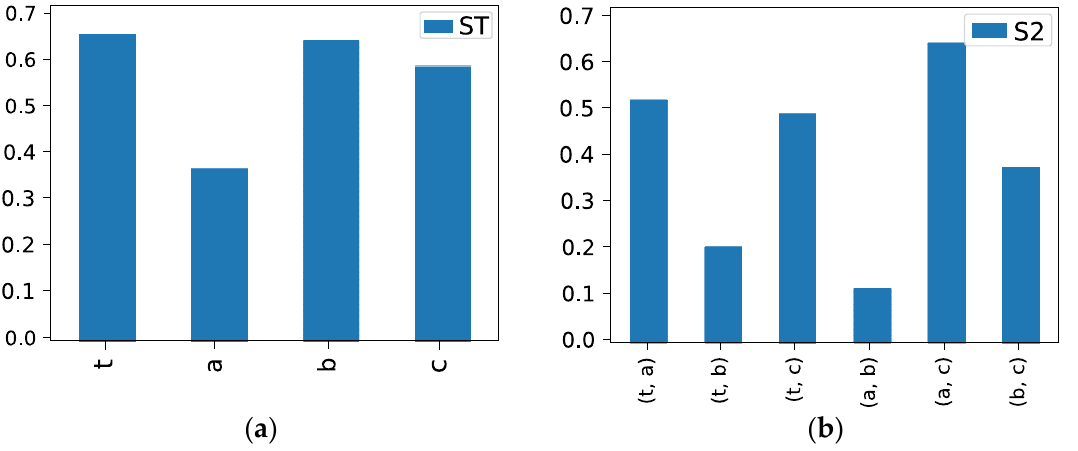
Figure 11. Sensitivity analysis of F m : ( a ) ST at 95% confidence level; ( b ) S2 at 95% confidence level.